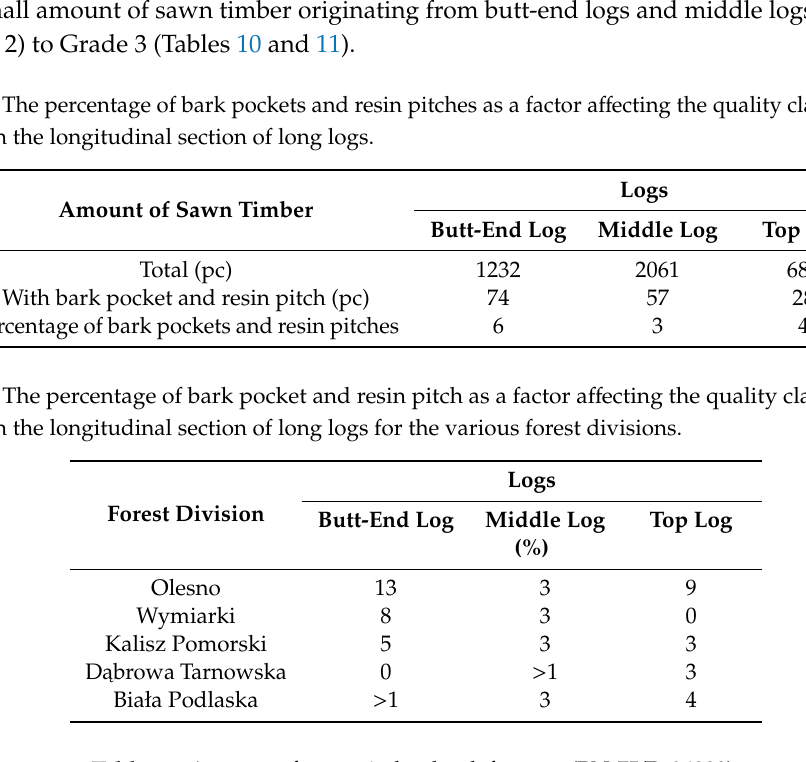
Table 10. Amount of sawn timber by defect: rot (PN-75 / D-96000).